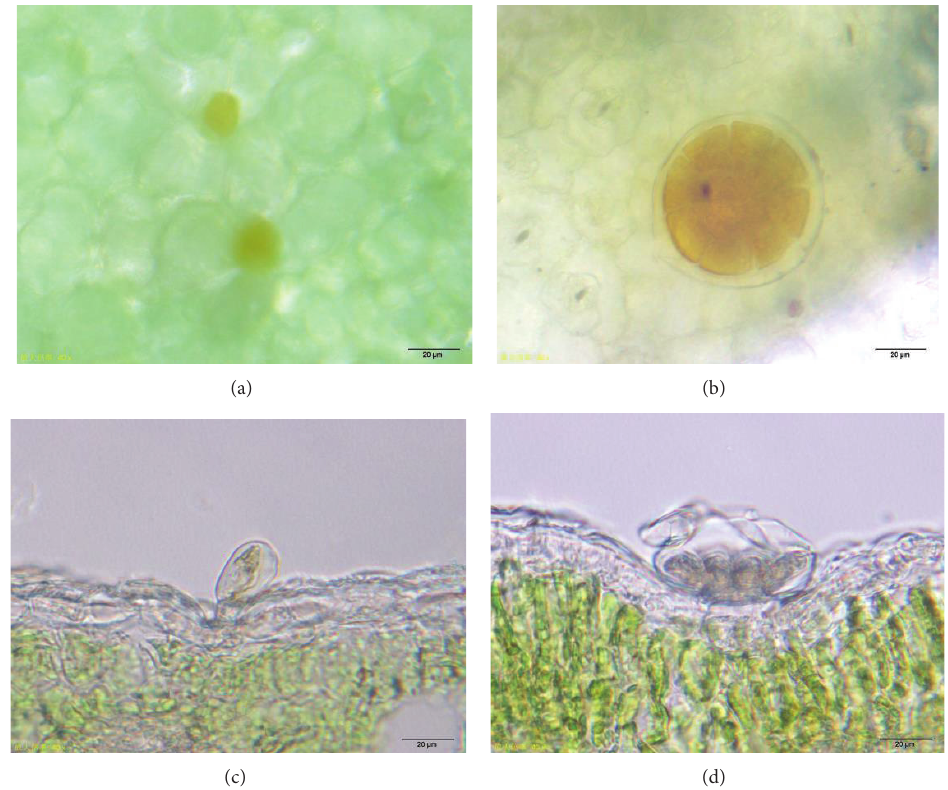
Figure 2: (a)-(b) Surface view of a mature leaf of T. quinquecostatus . (a) A capitate trichome dyed yellow. (b) A peltate trichome dyed yellow. (c)-(d) Transverse sections of a mature leaf of T. quinquecostatus. (c) The secretory cell of a capitate trichome dyed yellow. (d) The secretory cells of a peltate trichome dyed yellow.